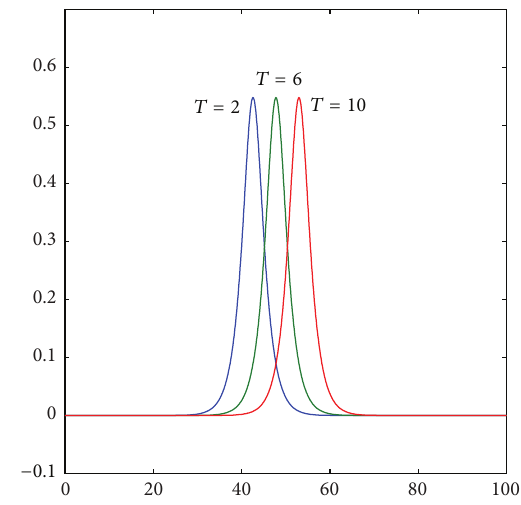
Figure 3: Solitary wave with 𝑐 = 0.3 , ℎ = 0.1 , 𝑘 = 0.01 and 𝑥 0 = 40, 0 ≤ 𝑥 ≤ 100 .